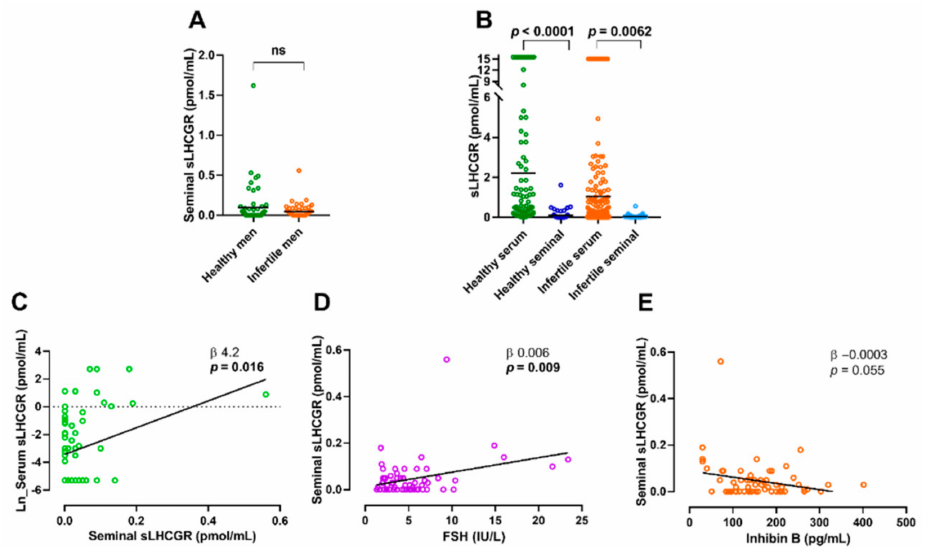
Figure 4. Seminal sLHCGR levels in normal and infertile men. ( A ): Seminal levels of sLHCGR in healthy and infertile men bar shows mean. ( B ): Serum vs. seminal level of sLHCGR in healthy and infertile men, bar shows mean and groups are compared using Wilcoxon Paired Test. ( C ): Linear regression showing associations between seminal and serum sLHCGR in infertile men. ( D ): Linear regression showing associations between seminal sLHCGR and serum FSH in infertile men. ( E ): Linear regression showing association between seminal sLHCGR and serum Inhibin